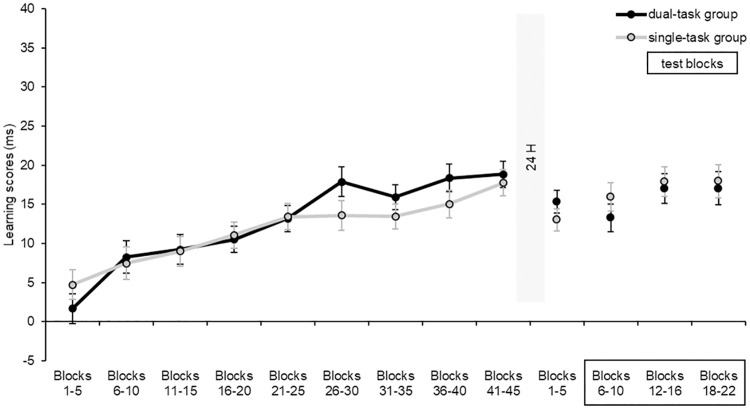
Learning scores of the two groups during the learning and the retrieval phase.The vertical axis represents the learning scores (the difference between RTs for high- and low-probability triplets) in ms, and the horizontal axis represents the nine units of five blocks of the learning phase (block 1–45) and the four units of five blocks of the retrieval phase (blocks 1–5, blocks 6–10, blocks 12–16, blocks 18–22). The black line represents the learning scores of the dual-task group, and the grey line the learning scores of the single-task group. The squared block units represent the test blocks, i.e., when the secondary task was also performed by the dual-task group. The error bars represent the standard error of the mean. At the beginning of the retrieval phase, stable statistical knowledge was detected in blocks 1–5. The statistical knowledge remained stable in the later parts of the retrieval phase, even during the test blocks, and no difference was found between groups in terms of learning scores. We found similar results with standardized scores.